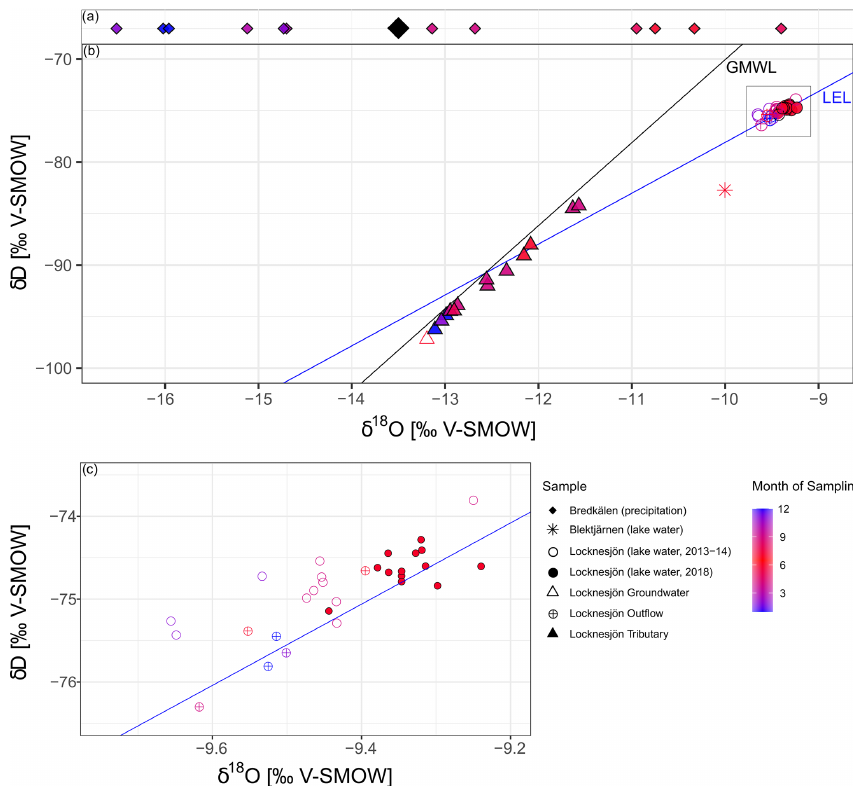
Figure 5. Isotopic composition of water in the study area. The symbols represent different locations and years of sampling. The color scale indicates the month of sampling, with blue values representing the cold period and red values representing the warm period of the year. (a) Average monthly δ 18 O of atmospheric precipitation for the period of 1975–1980 at the GNIP station Bredkälen (data from IAEA/WMO, 2019, note that δ D is not available for this station). The large black diamond shows the mean δ 18 O for 1976–1980 weighted by the amount of precipitation. (b) δ D and δ 18 O of lake water (sampled in 2013–2014 and 2018), the groundwater inflow (2018), and water in the tributary (2013–2014) and outflow (2013–2014) of Lake Locknesjön, and lake water from Lake Blektjärnen (2018). The Global Meteoric Water Line (GMWL), is plotted in black, and a local evaporation line (LEL; δ D = 4 . 9 · δ 18 O + 29) estimated from the isotopic composition of Locknesjön lake water in blue. (c) Zoom on the lake water isotope data from Lake